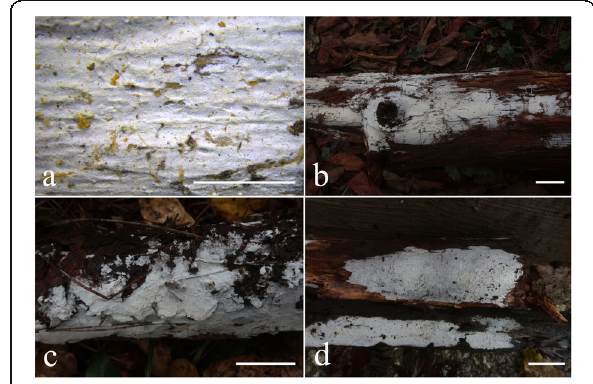
Fig. 8 Basidiomes of Skvortzovia dabieshanensis . a , b LWZ 20201012- 22 (holotype). c LWZ 20201014-18 (paratype). d LWZ 20201017-55 (paratype). Scale bars: a = 5 mm, b – d = 2 cm